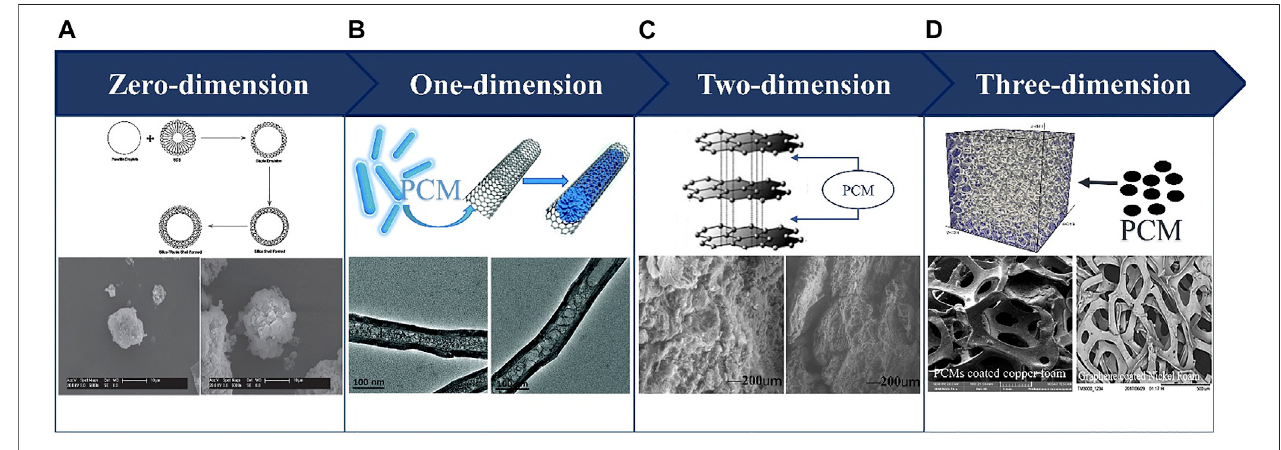
FIGURE5| Solid-liquidcompositephasechangematerials. (A) Encapsulation.Reproducedwithpermission(Lietal.,2018a).Copyright2018,Elsevier. (B) Carbon Nanotubes.Reproducedwithpermission (Aftabetal.,2018).Copyright2018,RSC. (C) Graphene.Reproducedwithpermission (MantillaGilartetal.,2012;Al-Shannaq and Farid, 2018). Copyright 2012 and 2018, Elsevier. (D) Metal Foam. Reproduced with permission (Abishek et al., 2018). Copyright 2018, Elsevier.